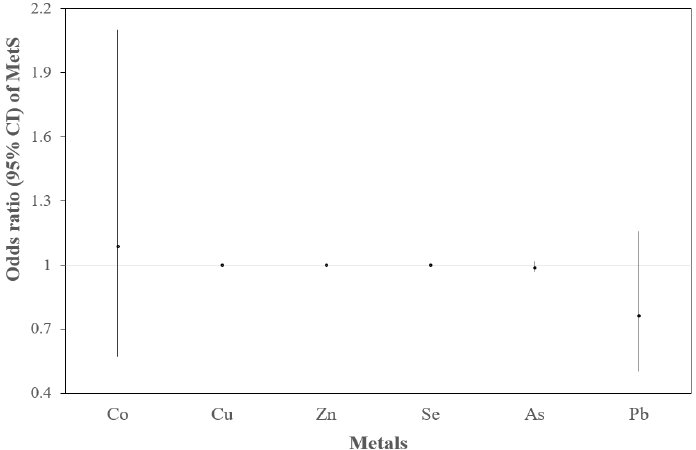
Figure 3. ORs and 95% CIs of MetS with 6 metals, respectively. Adjusted for age, gender, smoking, and drinking alcohol. The OR of MetS with Cu was 1.001 (95% CI: 1.000, 1.001). The prevalence of MetS had no association with Zn, Se, As, and the ORs were small (OR = 1.000, 1.001, 0.992, respec- tively).